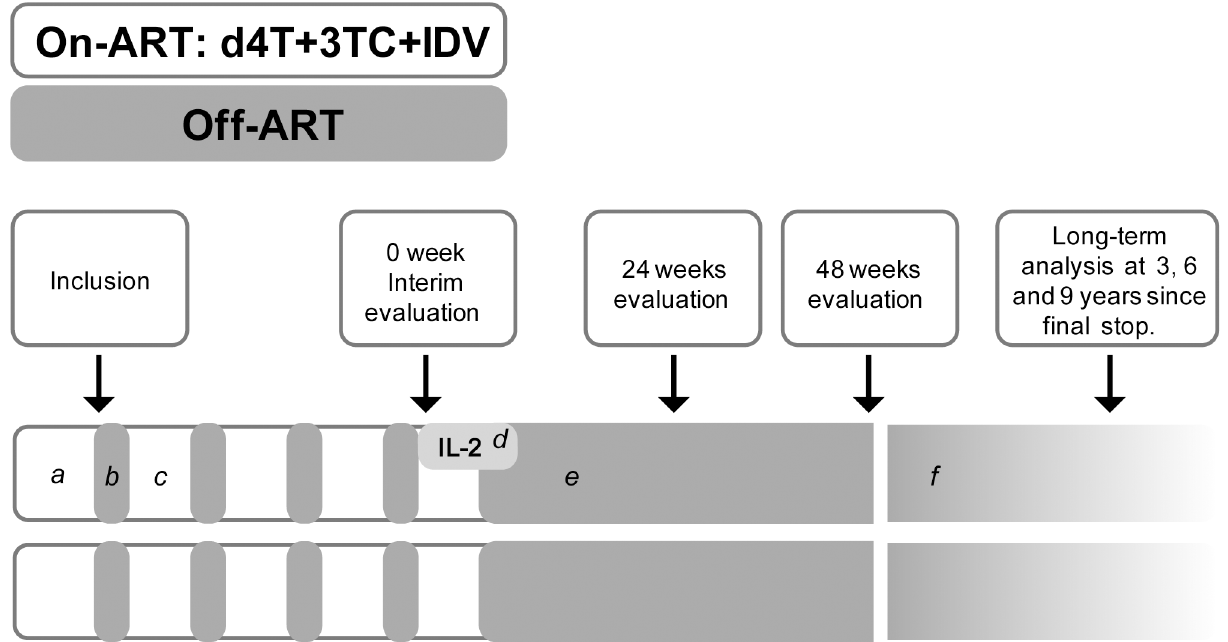
Fig 2. Design of the study. Footnote: (a) Eligible individuals were patients treated within 90 days of HIV exposure on stable ART for at least 12 months. Patients had to show good virological and immunological responses (at least 2 viral load < 20 copies/mL and CD4 T cells higher than 500 cells/mm3 with a CD4/CD8 ratio > 1). All individuals started four structured treatment interruption cycles (b) of 8 week each ( off-ART ), followed by four cycles (c) of treatment ( on-ART ). After the last treatment interruption (week 0) 6 patients started self-administrated IL-2 at a dose of 750,000 UI/m2 daily for 6 months (d). Treatment was interrupted in both arms when patients reached viral load < 20 copies/mL (e). Analyses were performed at 24 and 48 weeks and after a long term follow- up period (9 years). During this period (f) treatment was restarted in patients whose CD4 cell count dropped below 350 cell/mm3.